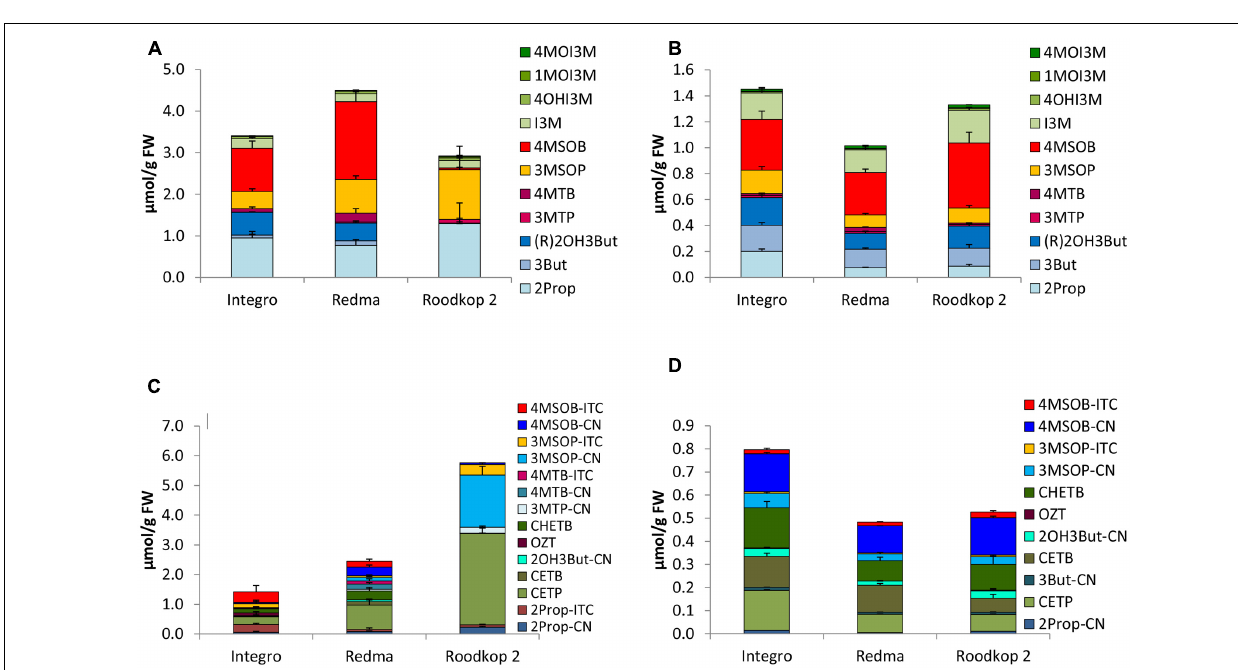
FIGURE 5 | Glucosinolates [ µ mol/g FW] and their hydrolysis products [ µ mol/g FW] in different cultivars of red cabbage in sprouts [ (A) GLSs, (C) hydrolysis products] and fully developed red cabbage heads [ (B) GLSs, (D) hydrolysis products]. Abbreviations: see Table 2 .